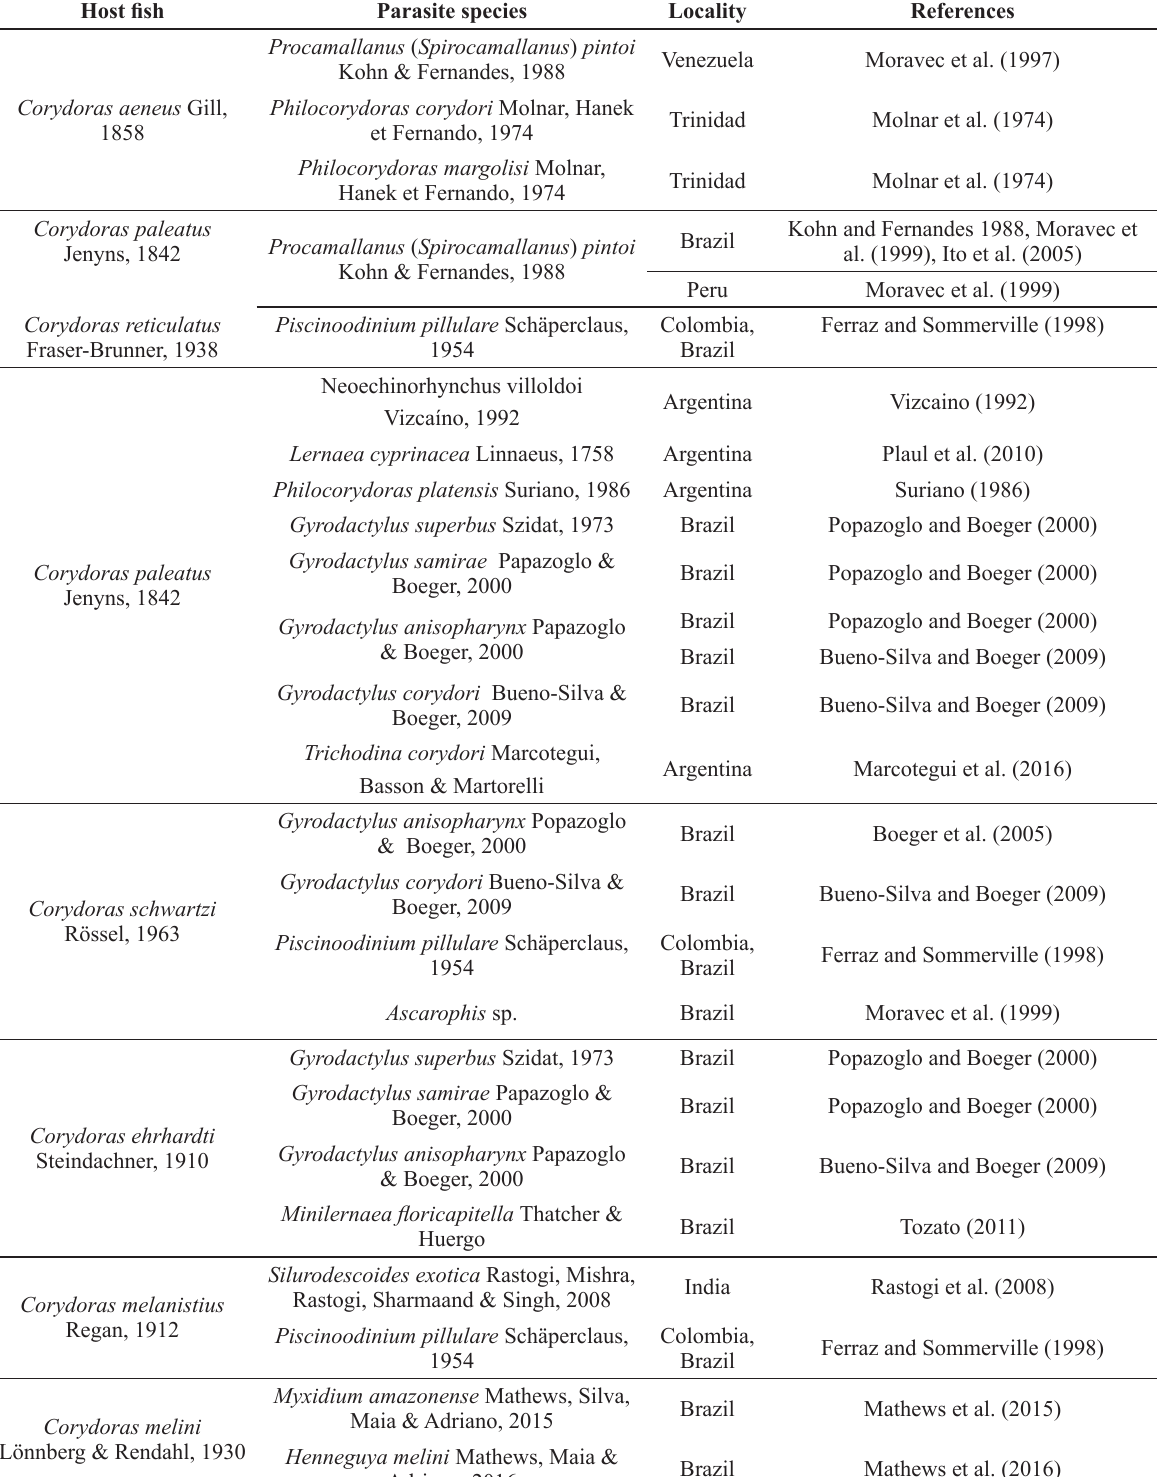
List of parasites in wild populations of Corydoras spp. from different